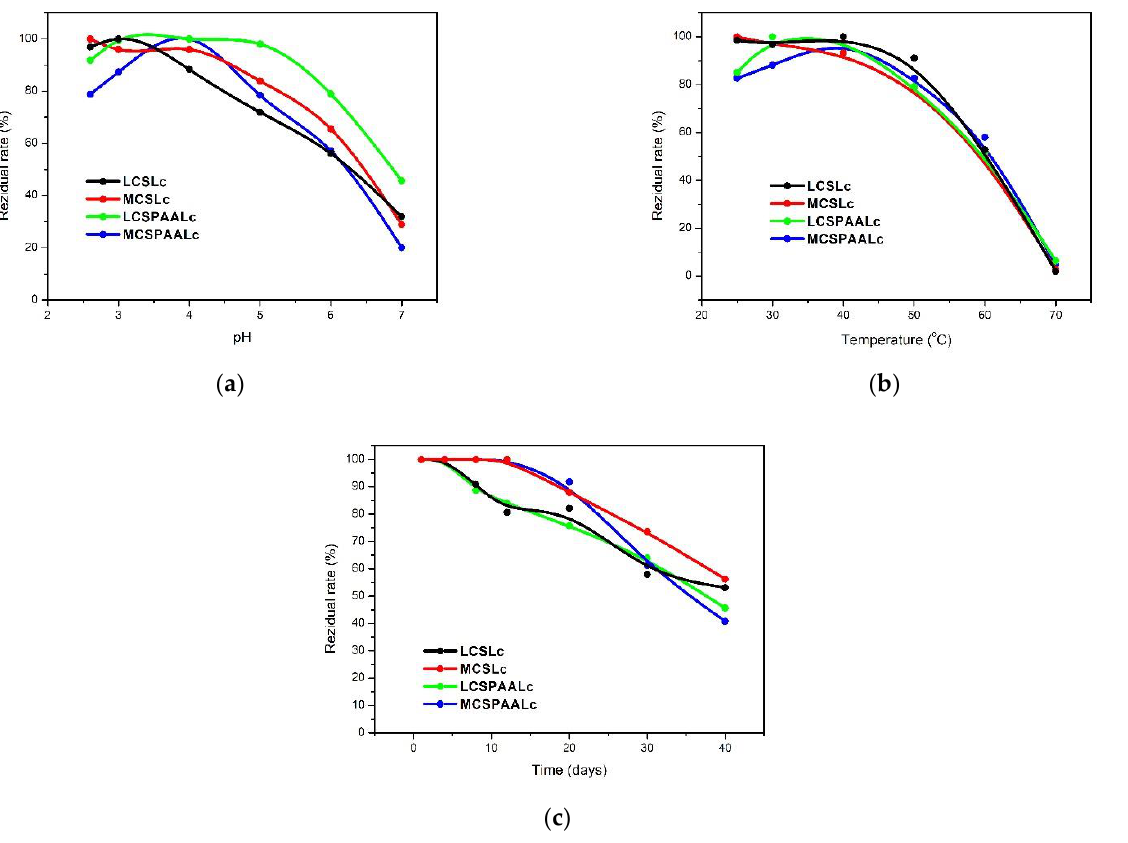
Figure 4. Effect of ( a ) pH, ( b ) temperature, and ( c ) storage on the immobilized Lc activity.